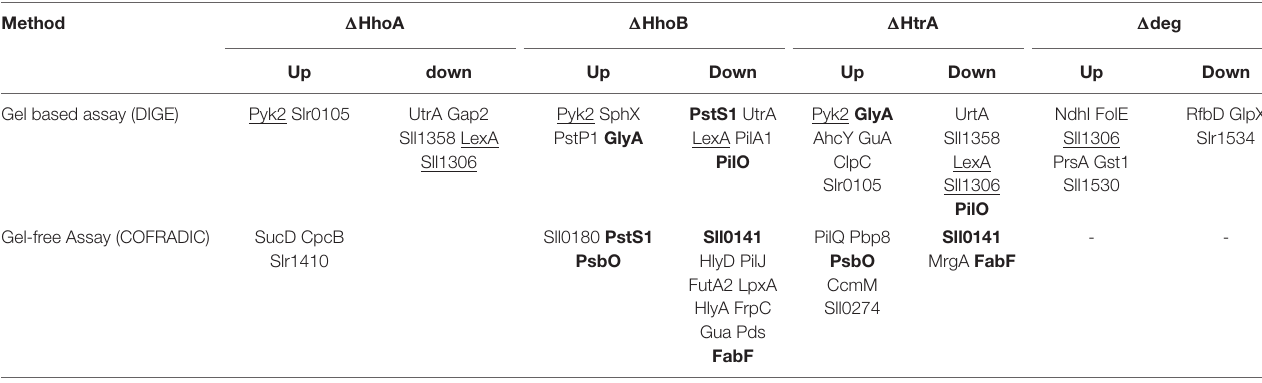
TABLE 1 | Differentially regulated proteins identified by gel based assay (DIGE; Cheregi et al., 2015; Lam et al., 2015) and gel free assay (COFRADIC; Lam et al., 2015) comparing WT Synechocystis 6803 with the single mutants (cid:49) hhoA , (cid:49) hhoB, and (cid:49) htrA or the triple Deg mutant ( (cid:49) deg ), grown at normal